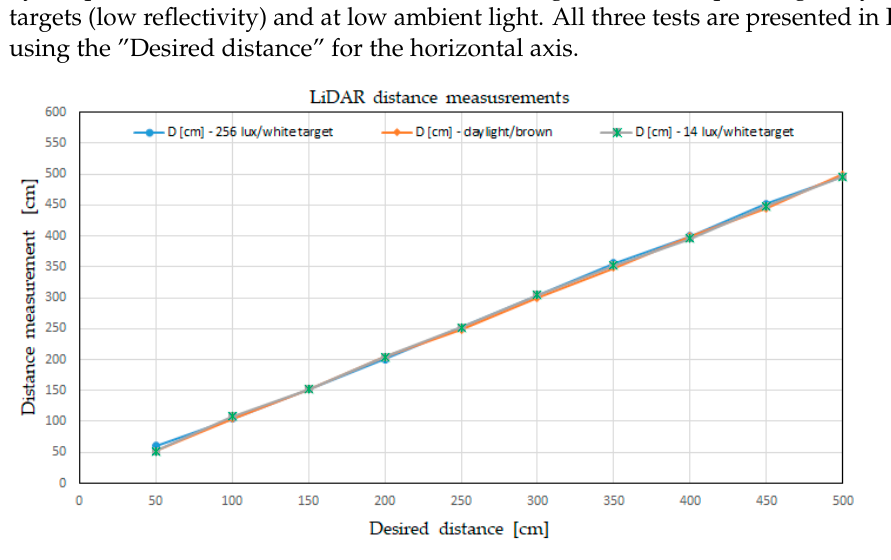
Figure 15. Plot of LiDAR distance measurements in various conditions The errors are presented in the Figure 16, where we can see that the LiDAR errors were mostly positives, meaning that the LiDAR was rounding the fractional values up